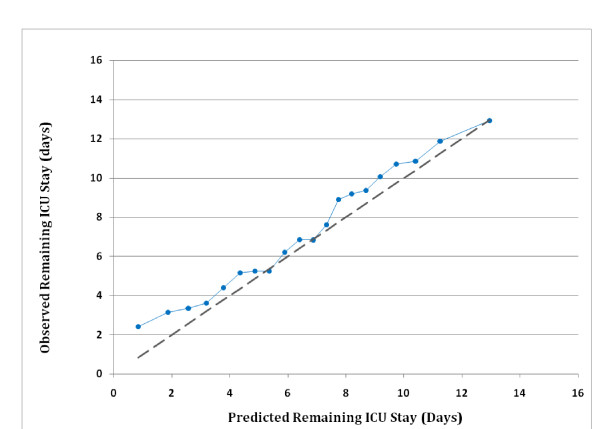
Calibration curve comparing mean observed and mean predicted intensive care unit (ICU) length of stay remaining on ICU day 5. The 11,903 patients in the 2006 to 2007 external validation set are divided into 20 equal-sized groups. The dotted line indicates perfect predictive ability (i.e. the observed means match the predicted means perfectly).